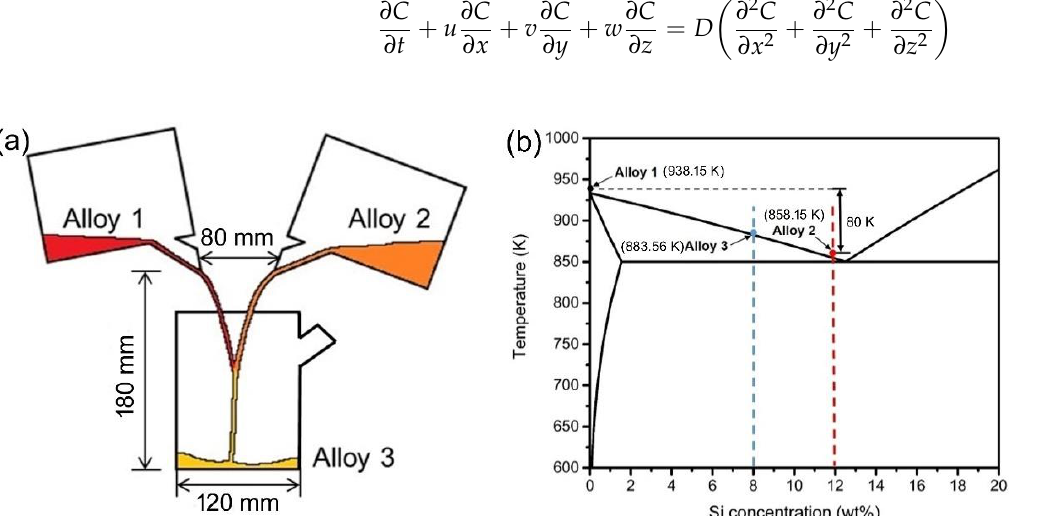
Figure 1. ( a ) Dimensions of the used model, and ( b ) temperatures and compositions of Alloy 1, Alloy 2 and Alloy 3 marked in Al–Si binary phase diagram. 2 and Alloy 3 marked in Al–Si binary phase